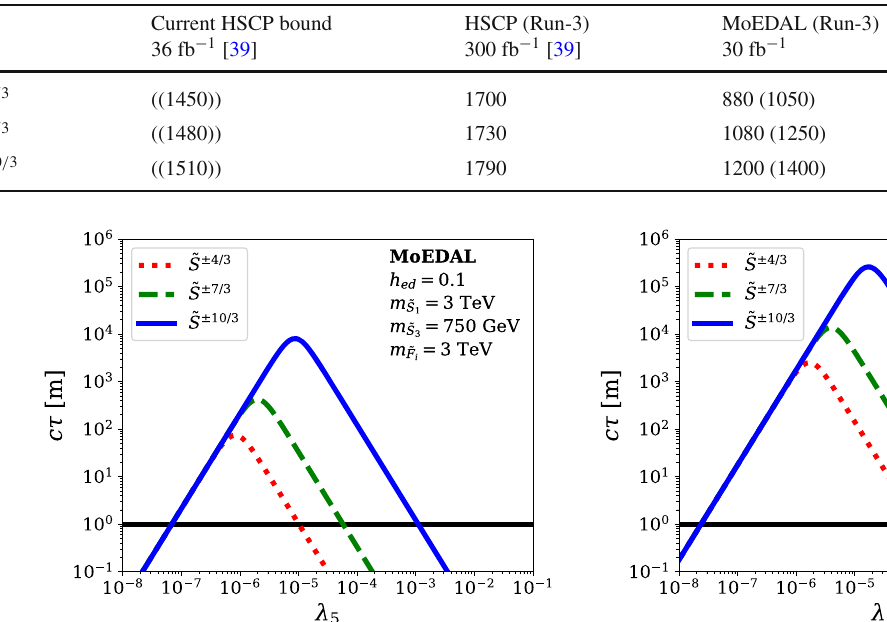
and 10 TeVinthe left andright plots, respectively. The other parameters = 750 GeV and m ˜ = 3 TeV ( i = 1 , 2 , are fixed as h ed = 0 . 1, m ˜ S 3 F i is taken to be 3 S 1